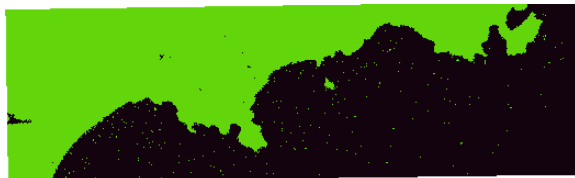
Figure 5. Extracted clusters, black: water surfaces, green: Land